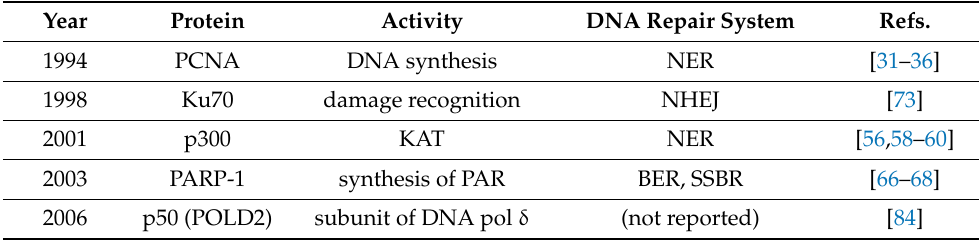
Table 1. Roadmap of the discovery of direct interactions of p21 with factors playing a role in DNA